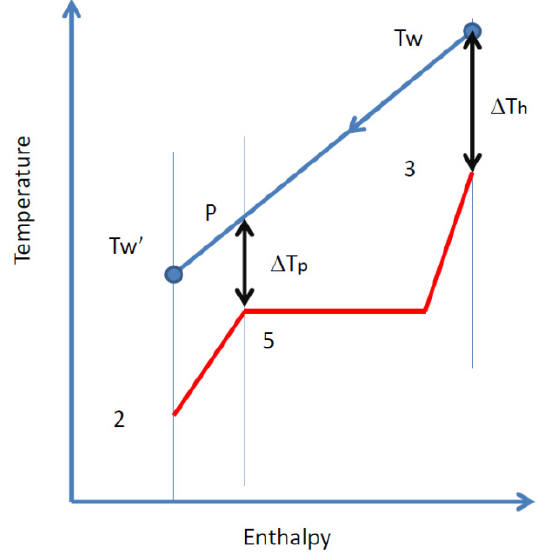
Figure 6. Temperature profiles of the heat source and the refrigerant in the